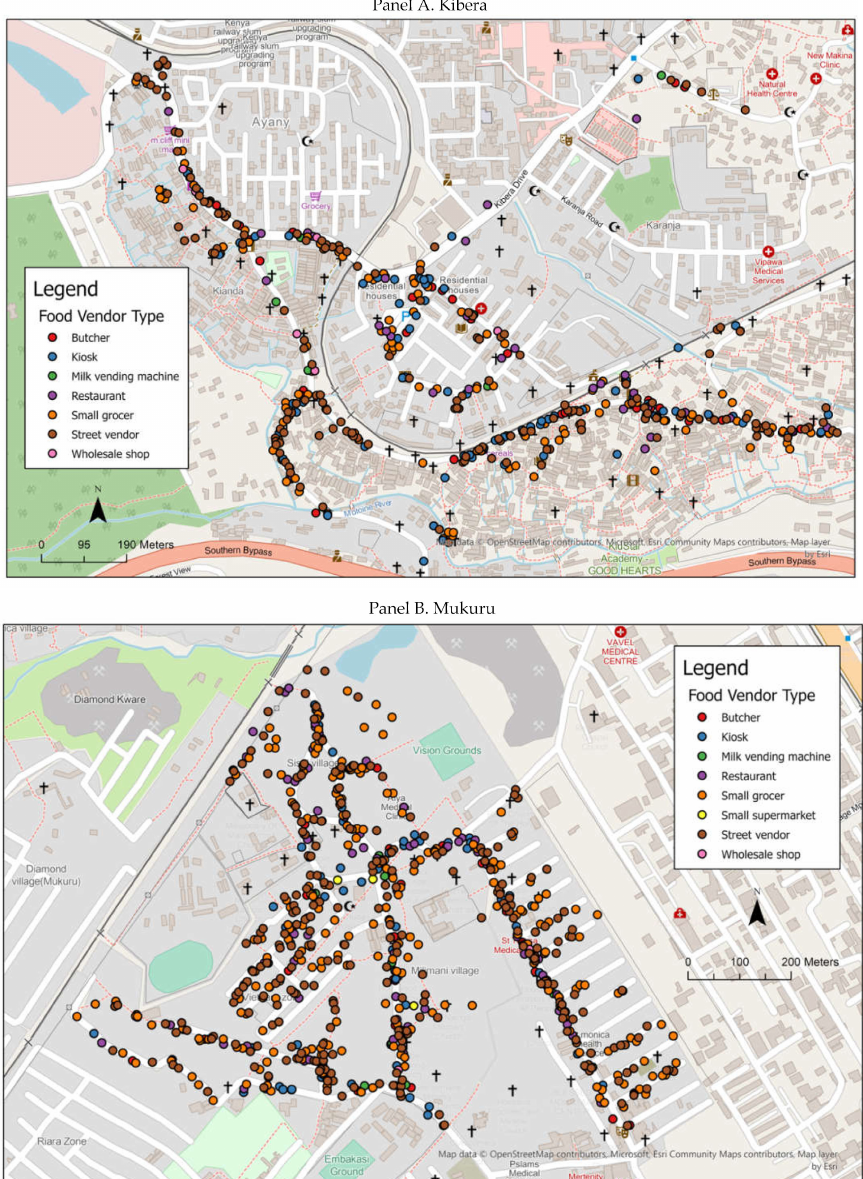
Figure 1. A map of the different types of food vendors in Kibera (Panel A ) and Mukuru (Panel B